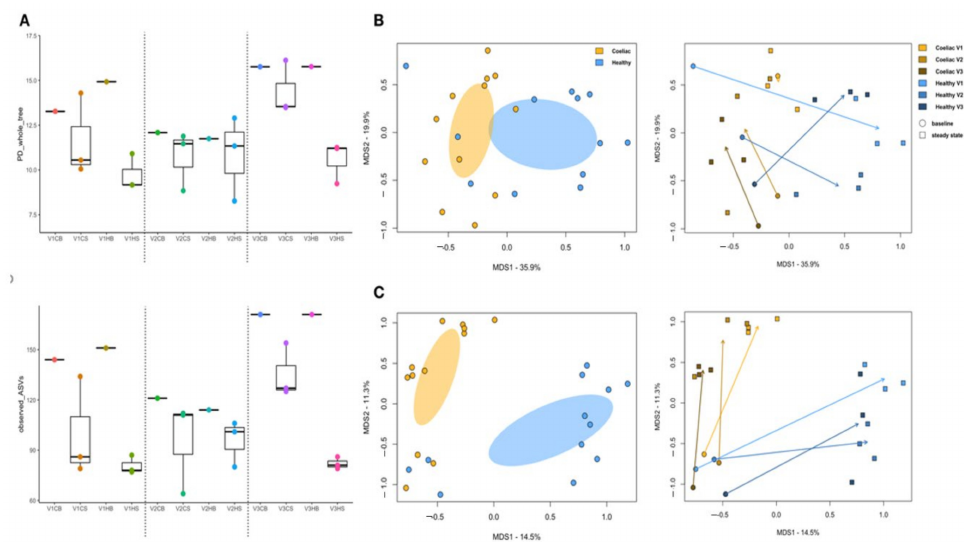
Figure 1. The faecal-derived microbial communities of the Coeliac donor ( n = 1) differ from those of the healthy donor ( n = 1) in fermentation experiments in the presence of C. pyrenoidosa extract (Sun Chlorella ‘A’ Powder). ( A ) Boxplots showing alpha diversity, measured according to Faith’s Phylogenetic Diversity index (PD whole tree) and observed ASV metrics, in fermentation samples from Coeliac ( C ) vs. healthy (H) donor, collected at baseline (SS1) ( B ) or after addition of C. pyrenoidosa upon reaching the steady state (SS2) (S), from the 3 vessels of the gut model (V1 vs. V2 vs. V3). Principal coordinates analysis (PCoA) based on weighted ( B ) and unweighted ( C ) UniFrac distances, showing all fermentation samples, stratified by sample origin (Coeliac vs. healthy, left panels) and fermentation condition/time point (vessel 1, 2 and 3; baseline vs. steady state; right panels). A significant separation between Coeliac and healthy samples was found regardless of all other variables ( p ≤ 0.002, permutation test with pseudo-F ratio). The arrows indicate the direction of the temporal variations observed within the faecal-derived microbial communities of the Coeliac vs. healthy subject in the three vessels, from the baseline to the steady